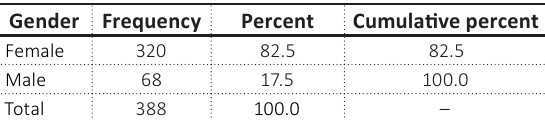
Table 9. Response on gender representation in